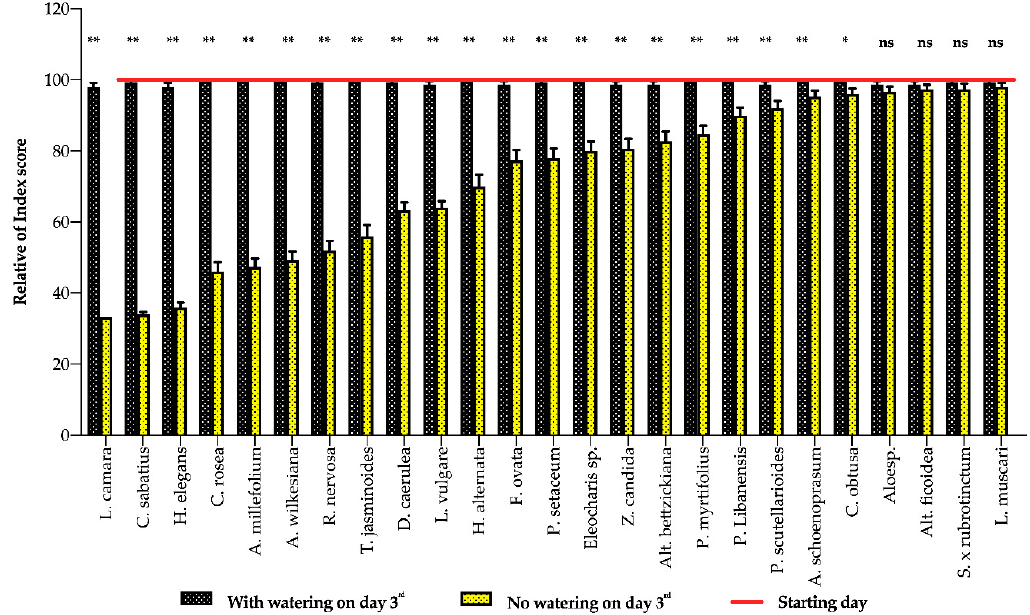
Figure 1. Effect of water deficiency on the relative aesthetic appeal index on the 3rd day of the experiment for different plant species. Bars and error bars represeant mean ± SE. Non significant (ns) and significant differences (* at p < 0.05 and ** at p < 0.01 by Student’s T-test between no watering at 3 days are shown above the bars.